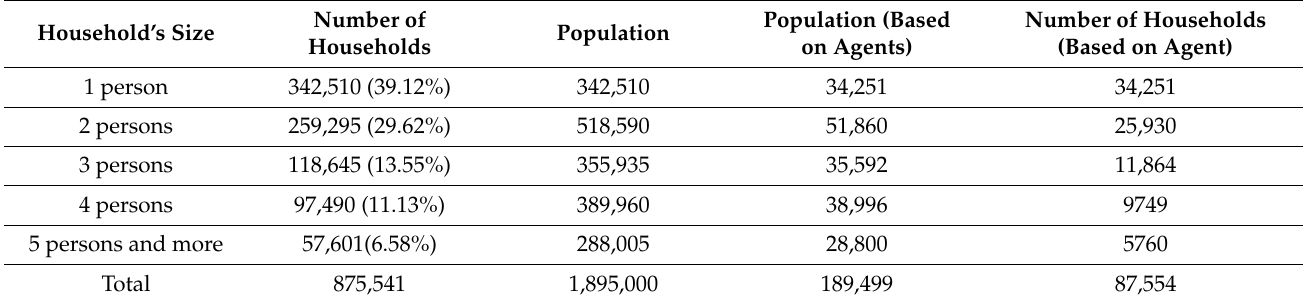
Table A2. The number of households based on household size (the year 2016).